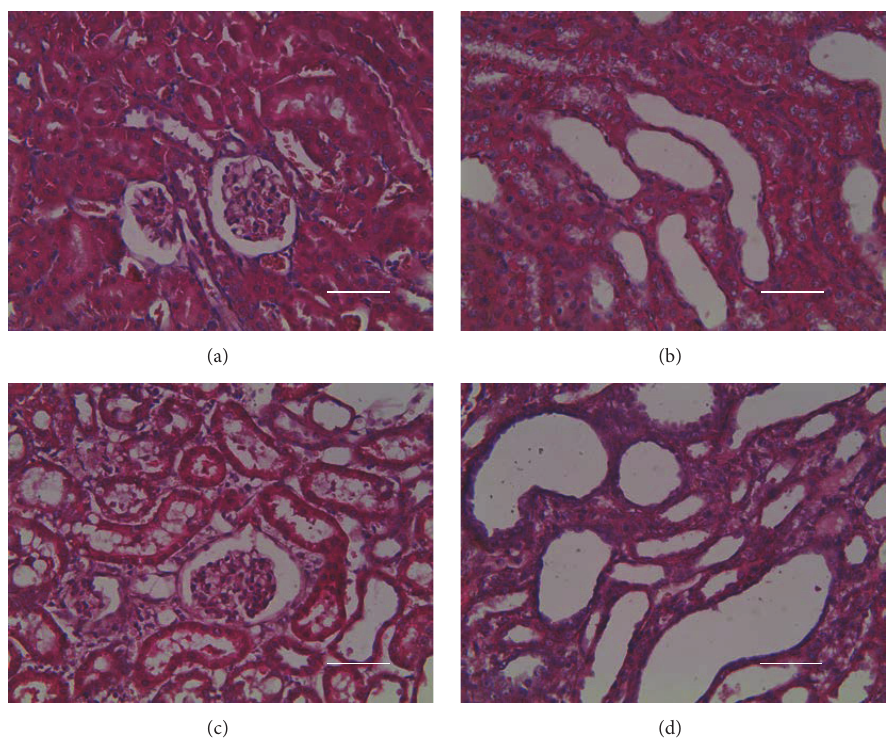
Figure 3: Micromorphology of rat kidneys in normal group ((a) and (b)) and kidney impaired group ((c) and (d)). Nephrocytes in normal group were piled tightly ((a) and (b)); there were no swelling signs in glomeruli (a) and tubules (b). While in kidney impaired group cells in the glomeruli were swollen and the capsular space was dilated (c), the wall of tubules became thin and piled loosely, and the space of tubules was also dilated (d). Rats in kidney impaired group were intragastrically treated with adenine (400 mg/kg × 5 days), while those in normal group were treated with normal saline of the same volume. Bar = 500 𝜇 m.